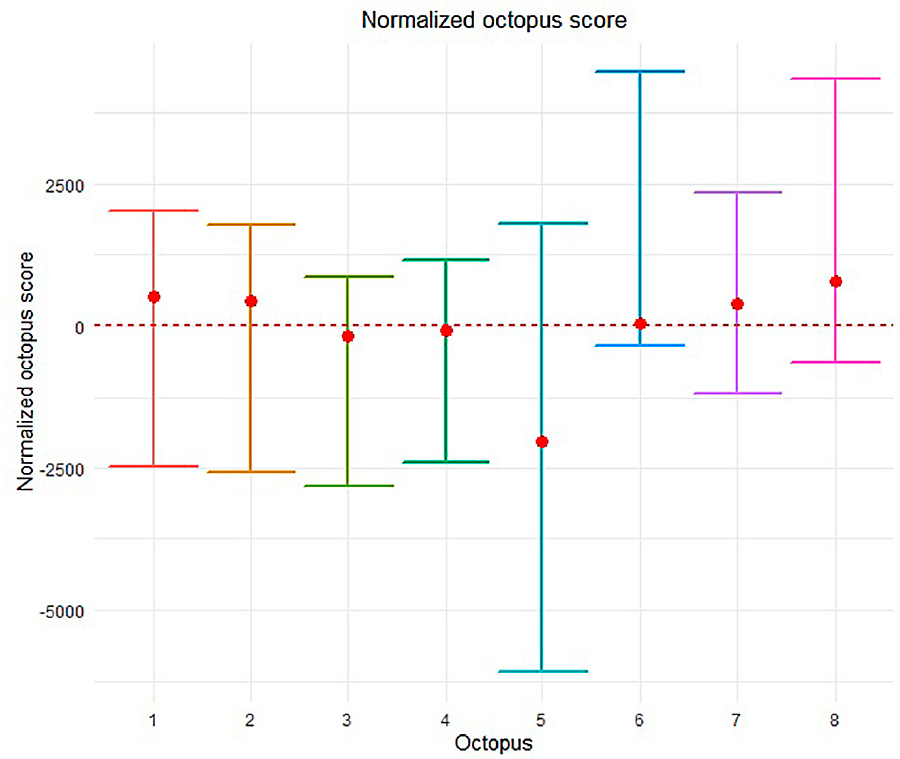
Fig. S1. – Distribution of the Octopus score “posteriors” to first capture (see Eq. 1). The red dot shows the median (or percentile 50%); the whiskers are the 95% Bayesian confidence interval (BCI; percentiles 2.5 and 97.5%)